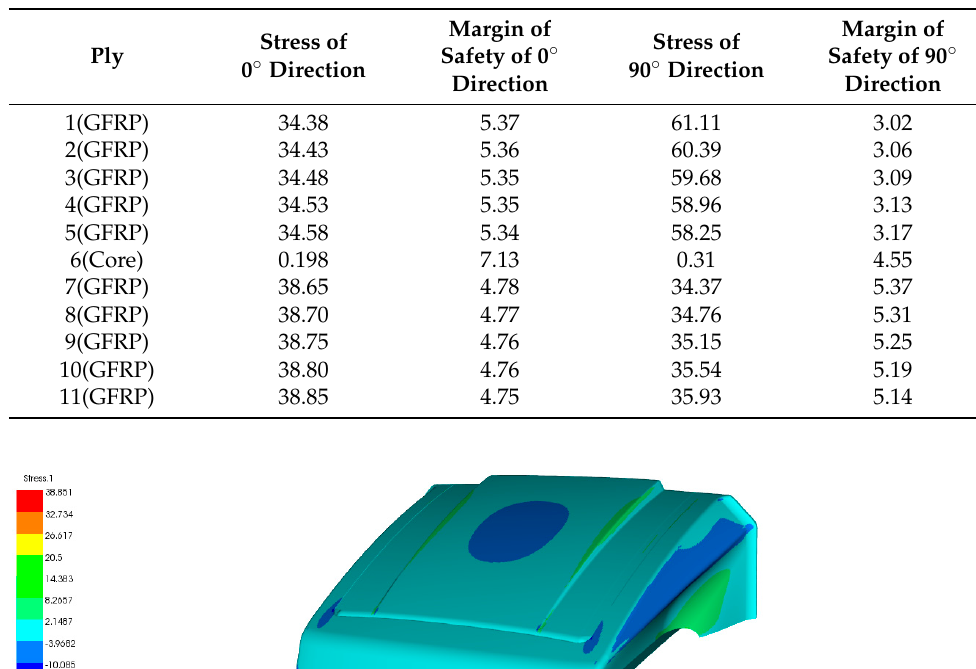
Table 7. Structural analysis result.